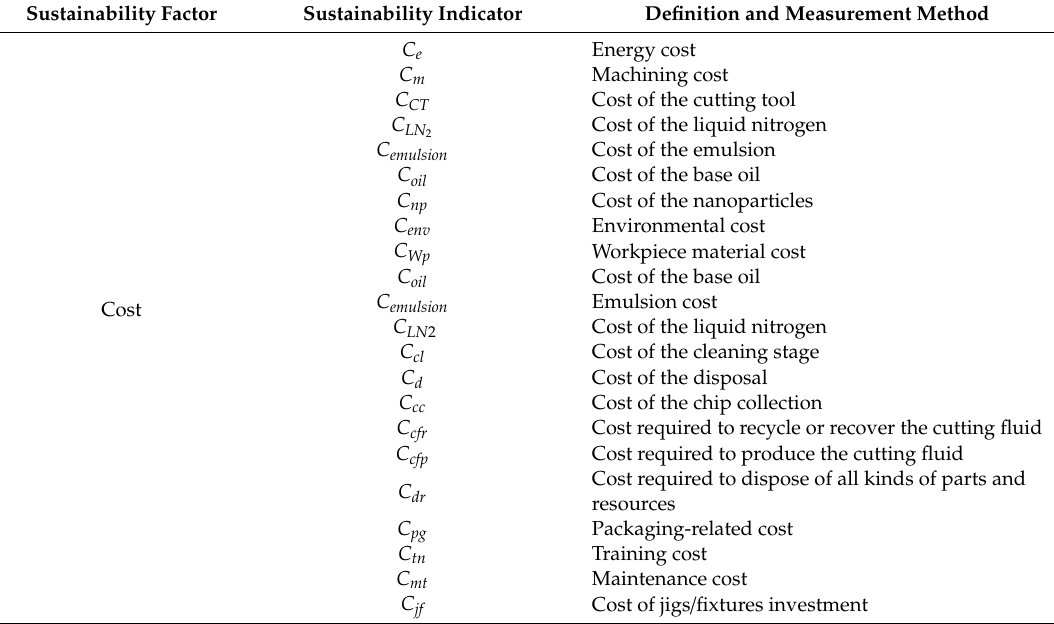
Table 2. Direct and indirect costs and their